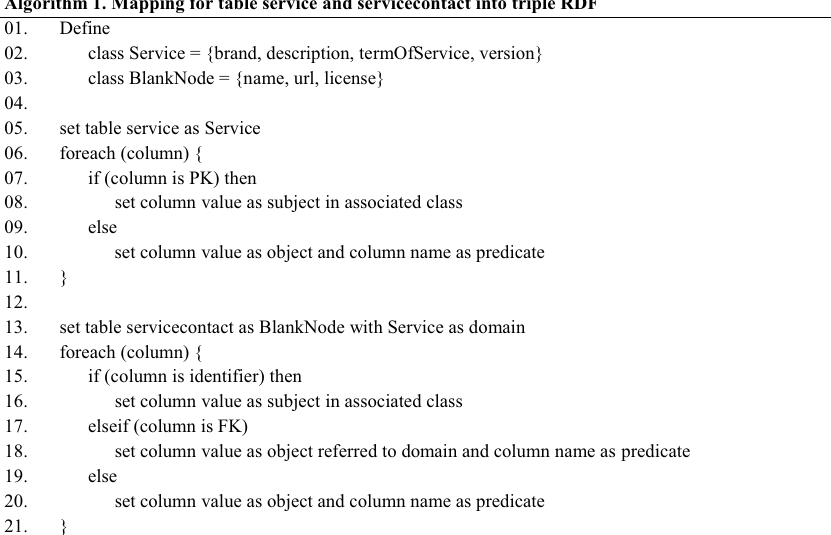
Algorithm 1. Mapping for table service and servicecontact into triple